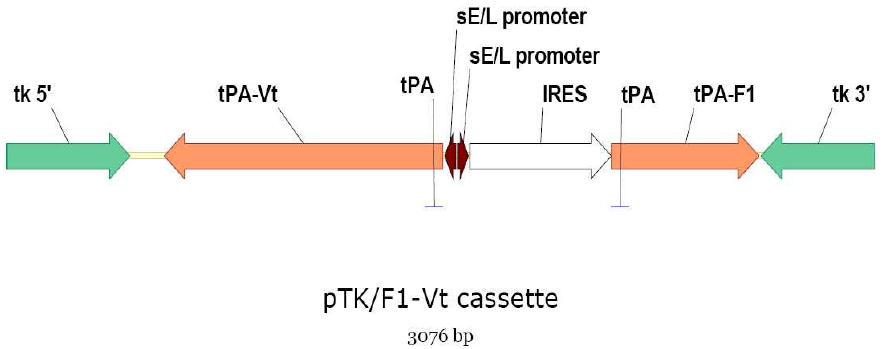
Figure 1. Schematic of the plasmid (pTK) used to produce the dual antigen plague vaccine construct, raccoon poxvirus expressing F1 and V antigens (RCN-F1/V307). The internal ribosomal entry site (IRES) was used as a translation enhancer for the F1 gene. The F1 and V genes were fused to the tissue plasminogen activator (tPA) secretory